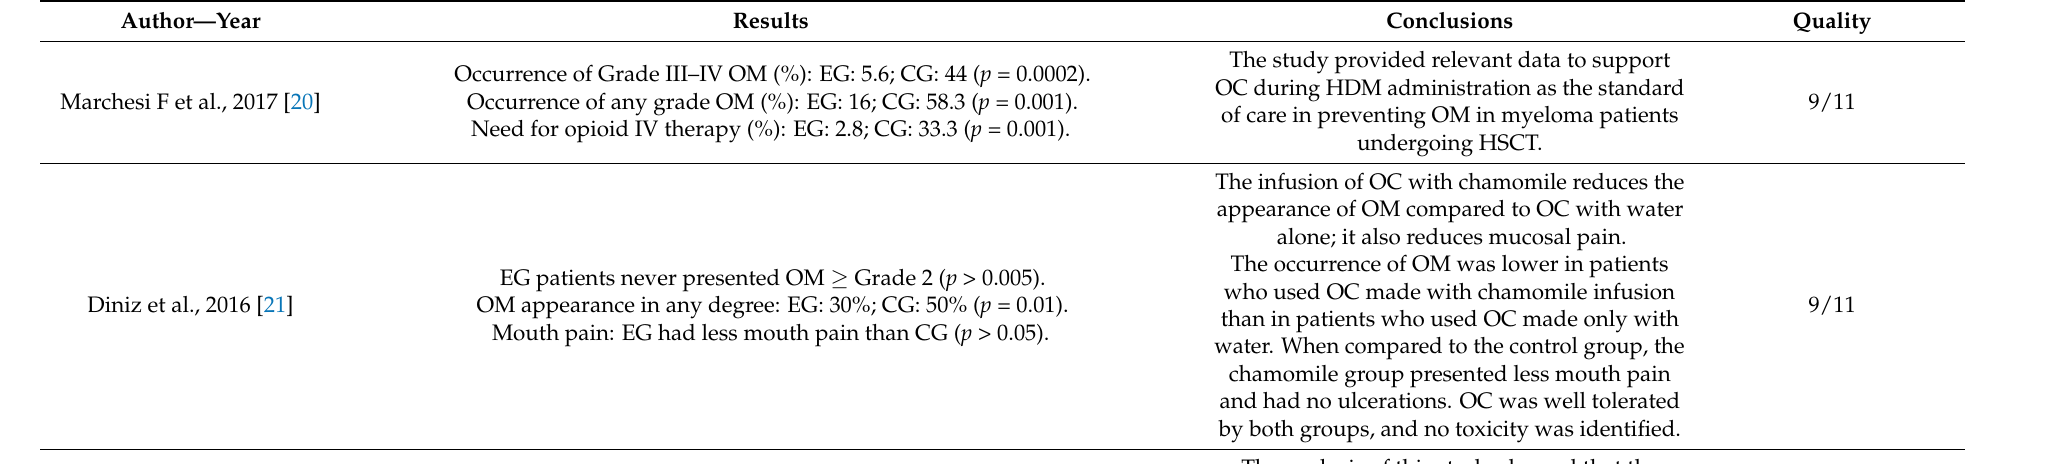
Table 3. Description of the results, conclusions, quality, and year of the selected